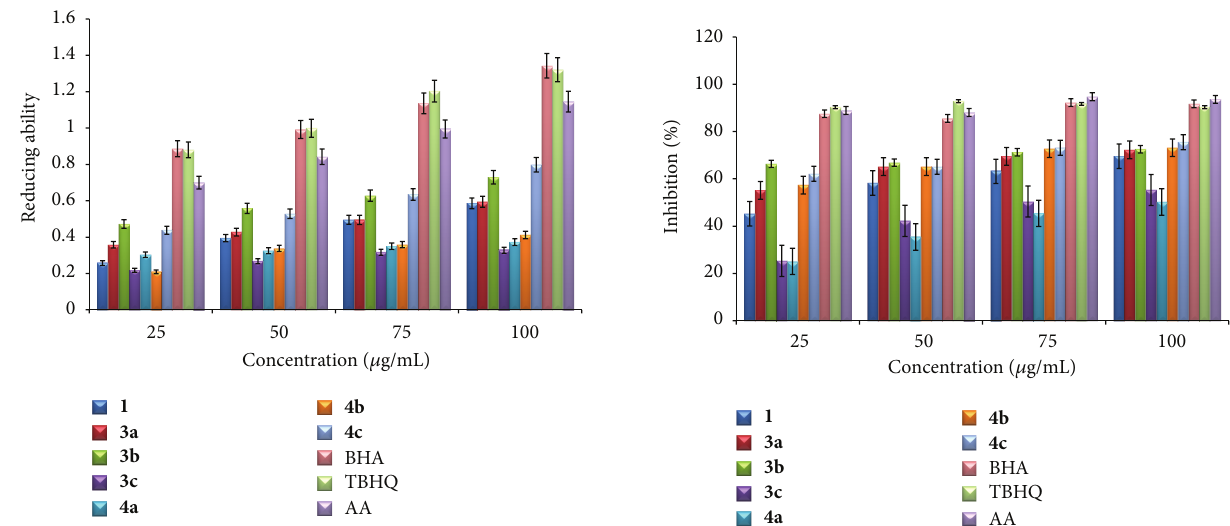
Figure 5: Metal chelating activity of the compounds ( 1 and 3-4